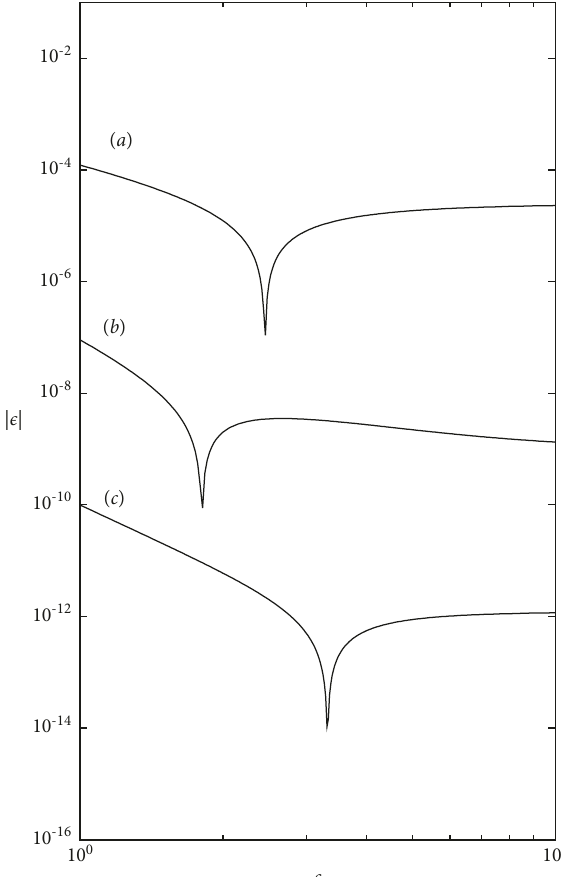
Figure 1: Absolute value of local truncation error ϵ RBF-FD approximation of u ′ as function of c using structured stencils with ( a ) n � 3, ( b ) n � 5, and ( c ) n � 7 ( u ( x ) � exp (− x 2 ) , h � 0 . 01, and x � 1).